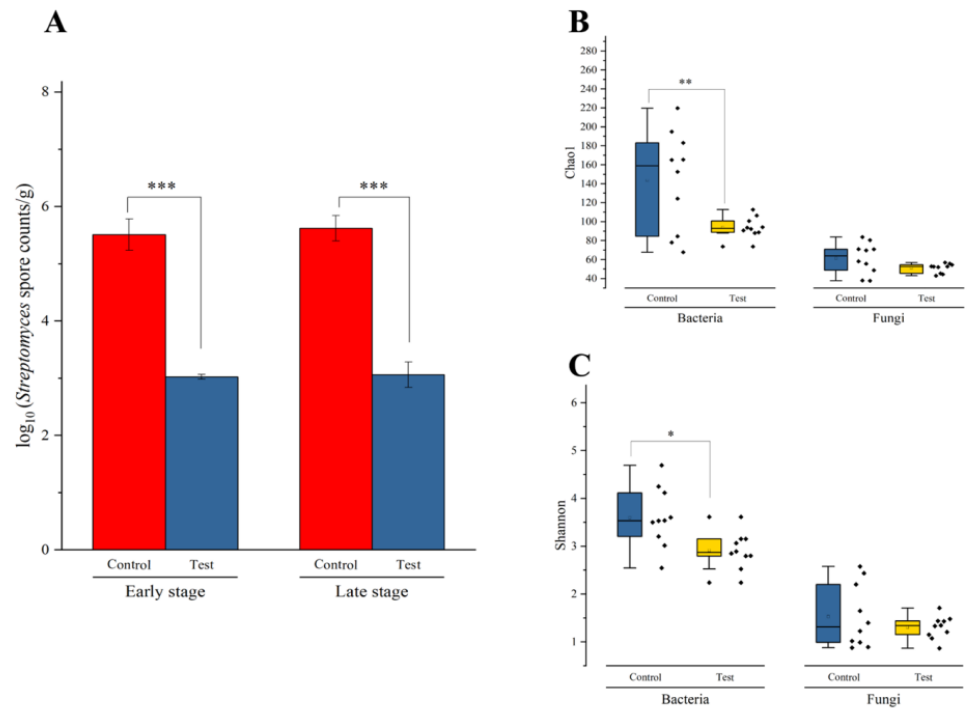
Figure 3. ( A ) The biomass of Streptomyces albus during the Daqu incubation process. ( B ) Chao1 index of microbial communities in the Daqu . Each point represented the Chao1 value. ( C ) Shannon index of microbial communities in the Daqu . Each point represented the Shannon value. *, p < 0.05; **; p < 0.01; ***, p < 0.001.